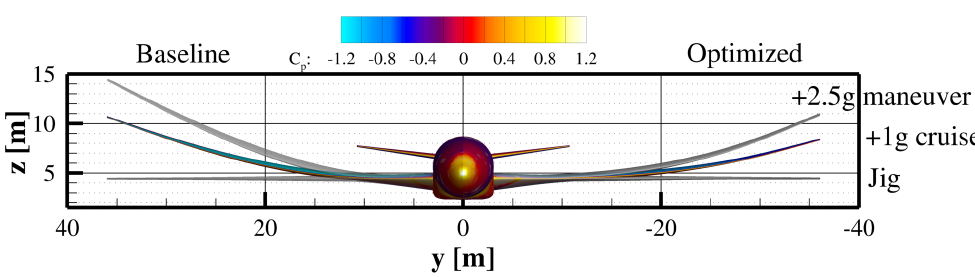
Figure 15. Baseline and optimized jig shapes and deflected geometries in 1g cruise and 2.5 g pull-up conditions (7-DoF airfoil parameterization).